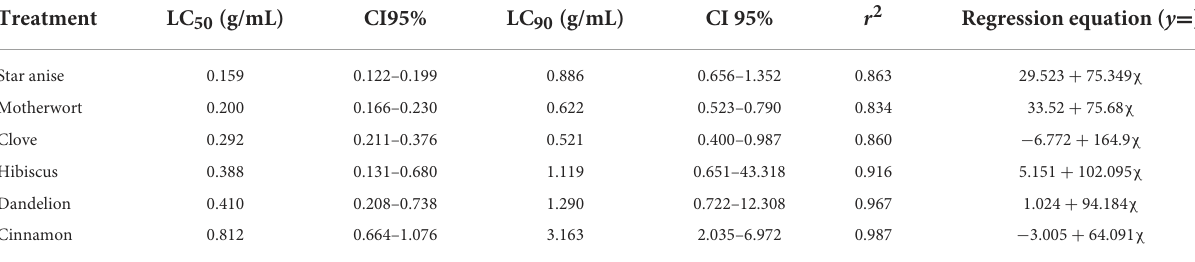
TABLE 3 Toxic effects of herbal alcohol extracts against adult Dermanyssus gallinae A .